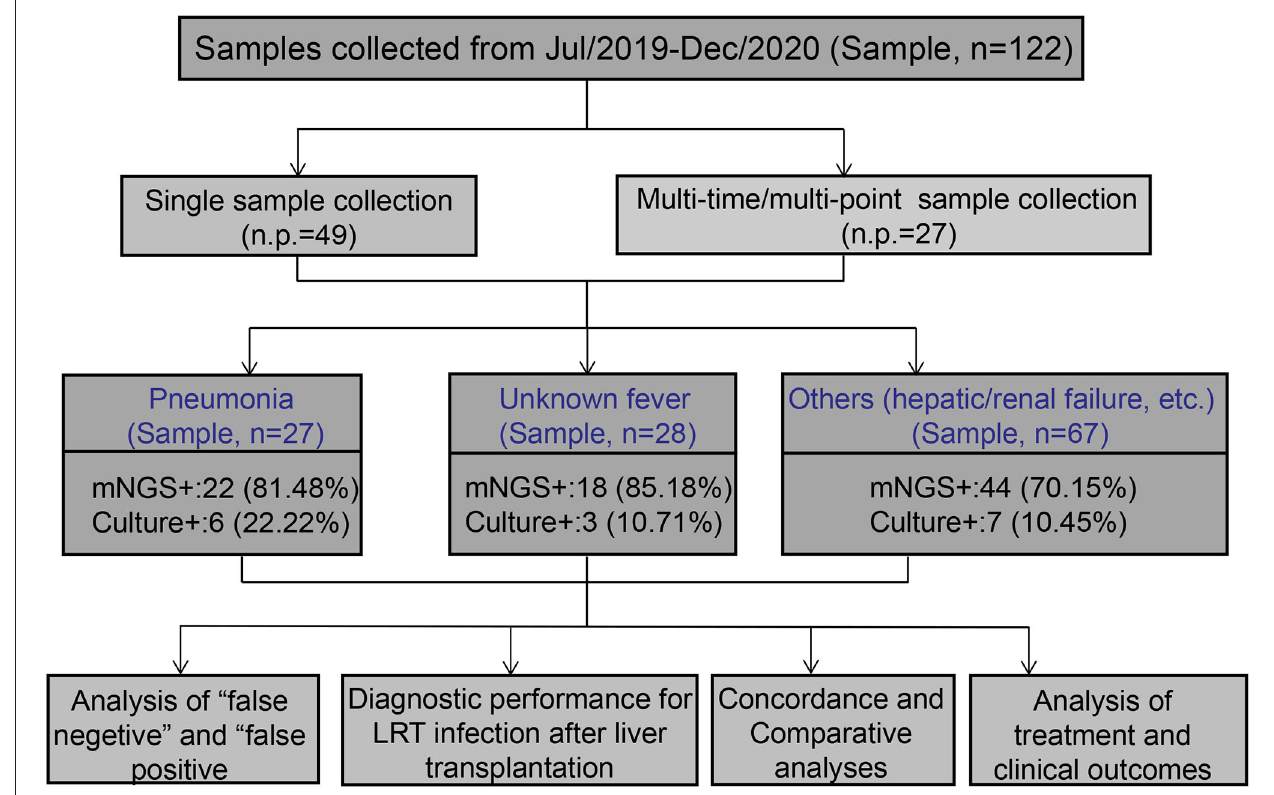
FIGURE 1 | Flowchart of sample selection, classification, and comparison. A total of 122 samples were selected for further analysis. Samples were divided into pneumonia, unknown fever, and others groups based on the retrospective analysis of the corresponding patients. All samples were examined for the concordance analysis of metagenomic next-generation sequencing (mNGS) and culture technique. LRT, lower respiratory